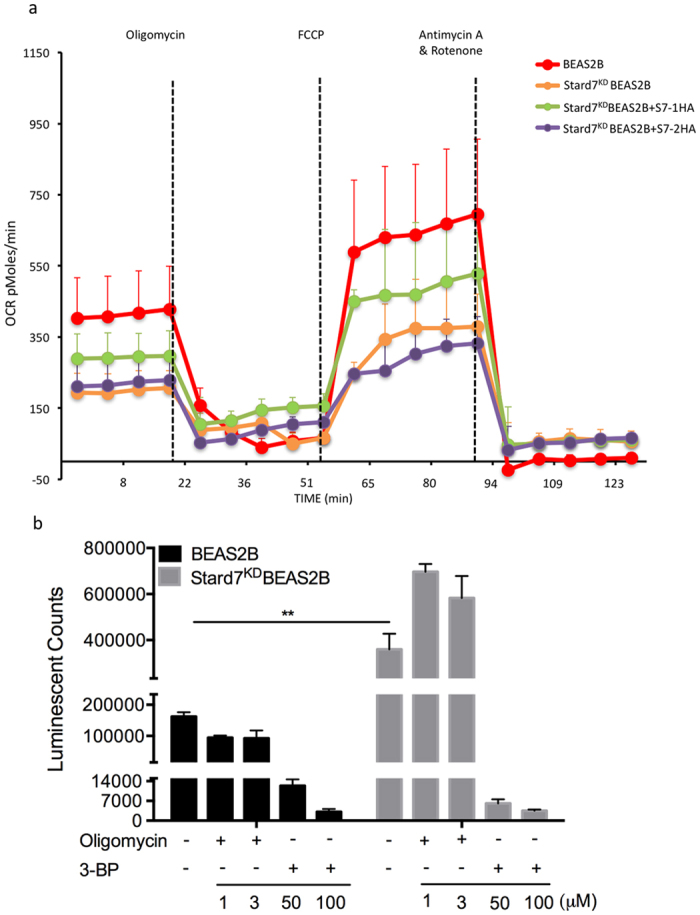
Stard7 deficiency is associated with altered mitochondrial function.(a) Mitochondrial OCR (pMoles/min) was measured under basal conditions and in response to the indicated mitochondrial inhibitors. The OCR was lower in Stard7KDBEAS-2B cells. Transient transfection of Stard7KDBEAS-2B cells with Stard7-1HA partially restored OCR (mean ± SEM, n = 5). (b) BEAS-2B and Stard7KDBEAS-2B cells were treated with or without the indicated concentration of 3-BP or oligomycin for one hour and cellular ATP levels were determined. Data represent the averages of three independent experiments (mean ± SEM). BEAS-2B cells vs. Stard7KDBEAS-2B cells, **p = 0.0078. OCR: oxygen consumption rate. FCCP: carbonyl cyanide p-trifluoromethoxyphenylhydrazone. 3-BP: 3-bromopyruvate.